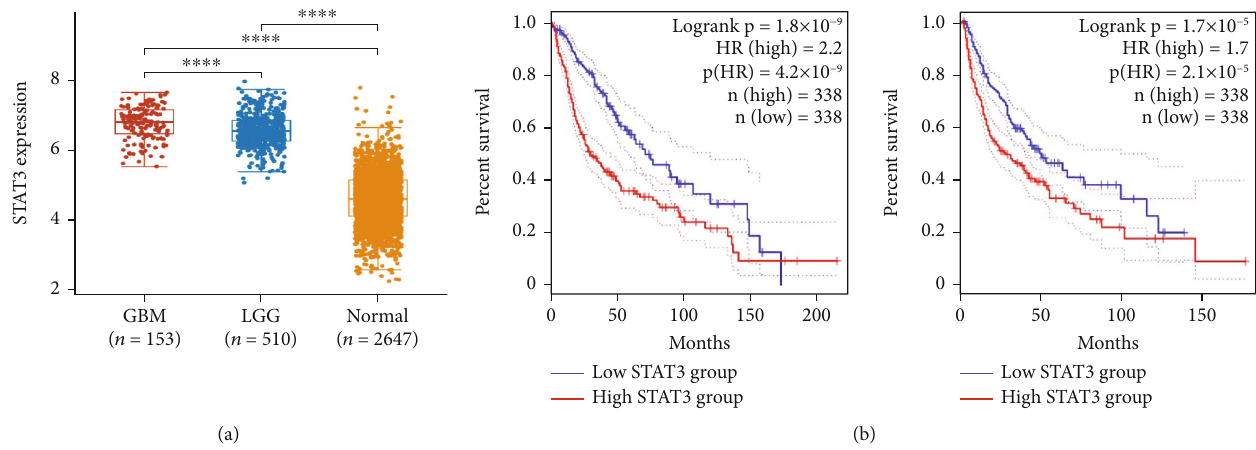
Figure 3: The expression of STAT3 and its prognostic value in glioma. (a) The expression of STAT3 was distinctly increased in GBM and LGG specimens compared with nontumour specimens based on TCGA datasets. (b) Patients with high STAT3 expression showed a shorter OS and PFS than those with low STAT3 expression in patients with GBM and LGG based on TCGA datasets. ∗∗∗ ∗ p < 0 : 0001